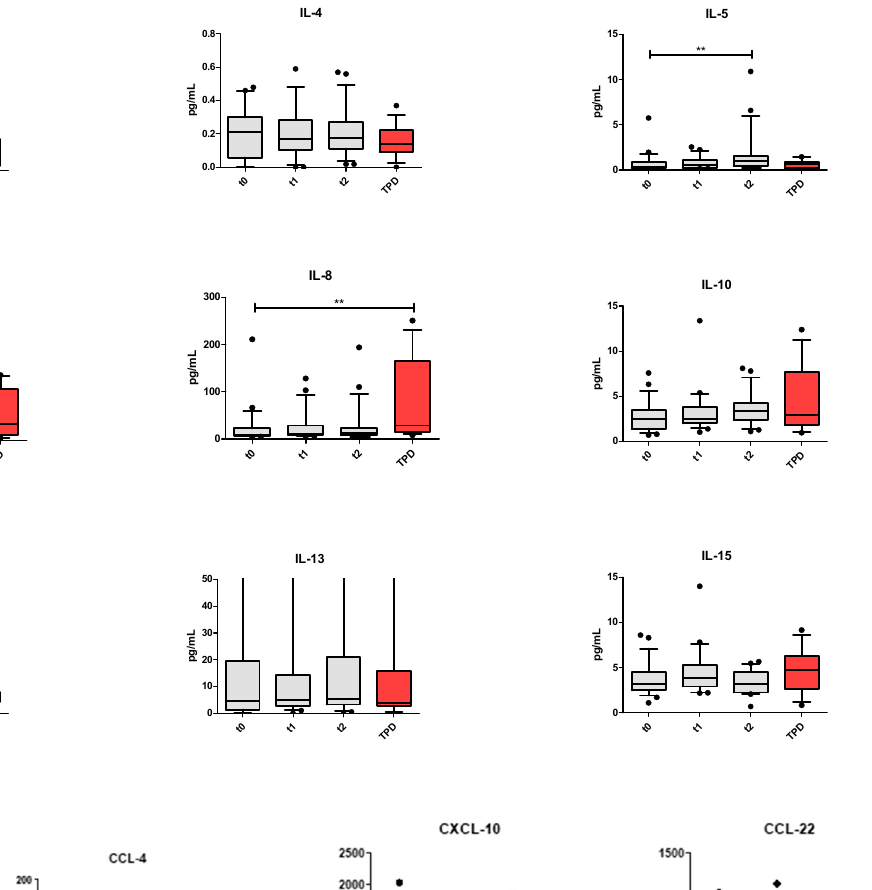
10 of 16 Figure 6. Distributions of cytokines among four areas: orange bars for area 1 (4 pts), red bars for area 2 (5 pts), green bars for area 3 (7 pts) and blue bars for area 4 (7 pts). Concentrations are express in pg/mL. Only p values corrected for multi-